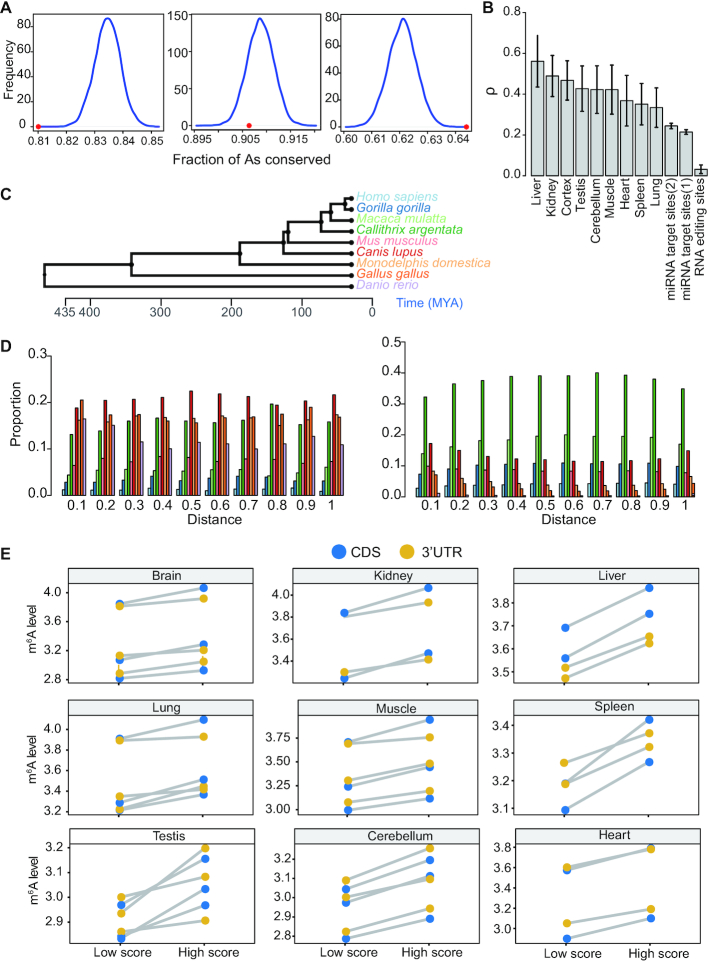
Natural selection on m6A inferred by cross-species analysis. (A) Comparison of evolutionary conservation between m6A and control A sites (non- m6A RRACH). Frequency distributions of the fraction of conserved control sites in 10,000 random sets with the sample size equal to the number of m6A sites at three codon positions were plotted separately. Red dots indicate the fraction of conserved m6A sites. P is the fraction of the distribution on the right side of the dots. First codon, P = 1; second codon position, P = 0.89; third codon position, P <0.0001. (B) Estimates of ρ for m6A RRACH motifs, A-to-I RNA editing triplet motif and miRNA binding sites. ρ represents the fraction of sites under selection within functional elements, which is calculated by INSIGHT. m6A sites, m6A RRACH motifs in 3′UTR region; RNA editing sites, nonrepetitive A-to-I RNA editing sites in 3′UTR region; miRNA target sites, 3′UTR miRNA binding sites for conserved (1) or broadly conserved (2) miRNA families. The regions that match the seed region of the miRNAs were used for analysis. (C) A tree representing the schematic phylogeny of the species studied. (D) The age distribution of m6A sites (left) and control non-m6A RRACH sites (right) across the 3′UTR region. m6A sites and control sites were grouped into 10 bins based on their distance to stop codon. The age of a site was based on the most distantly related species in which the site was conserved. The color codes for the age are the same as in (C). (E) Comparison of methylation levels between m6A sites under strong and weak constraints in CDS and 3′UTR. m6A sites with top 25% (High score, strong constraint) and bottom 25% (Low score, weak constraint) rejection scores were compared. m6A peak winscore of a site was used to represent m6A level. Each dot represents the median methylation level of the CDS or 3′UTR sites; biological replicates of each tissue type were plotted, separately.